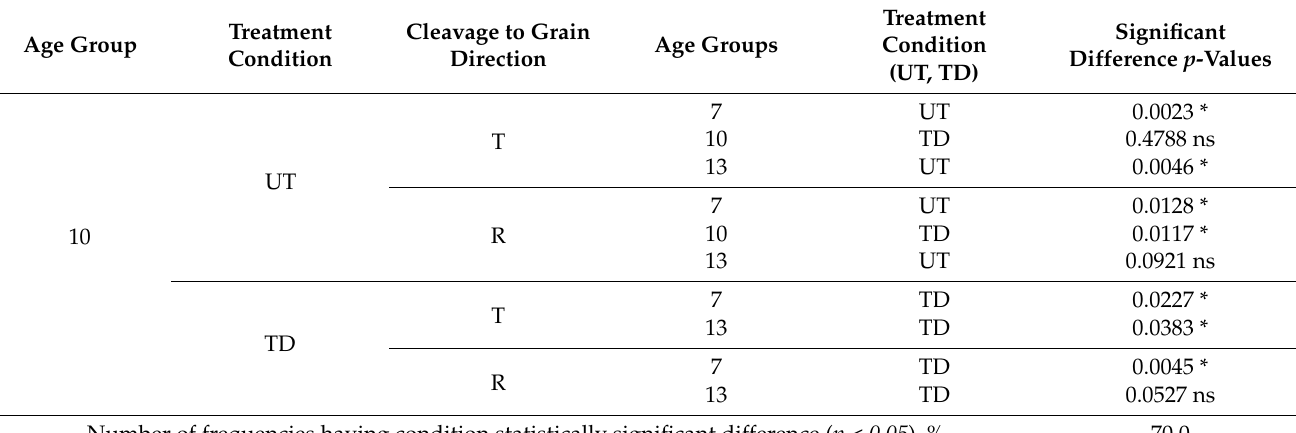
Table 4. ANOVA on the effect of age groups, treatment conditions, and grain directions with 10-year- old untreated and treated cleavage of Acacia hybrid samples at air-dry